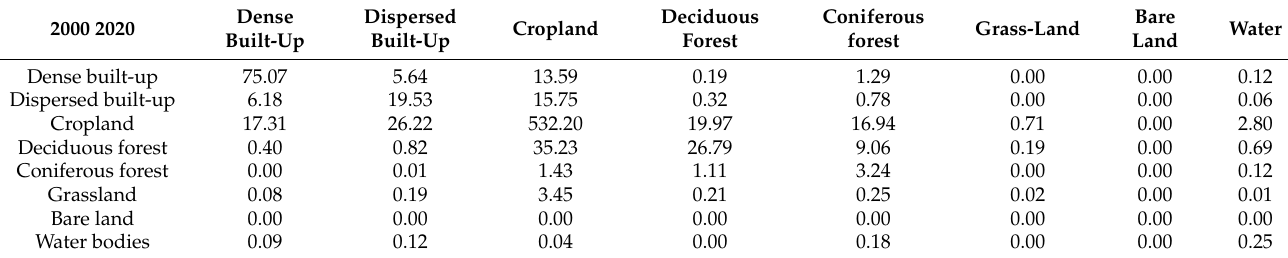
Table A4. Land cover area transfer matrix for Aarhus from 2000 to 2020 (km 2